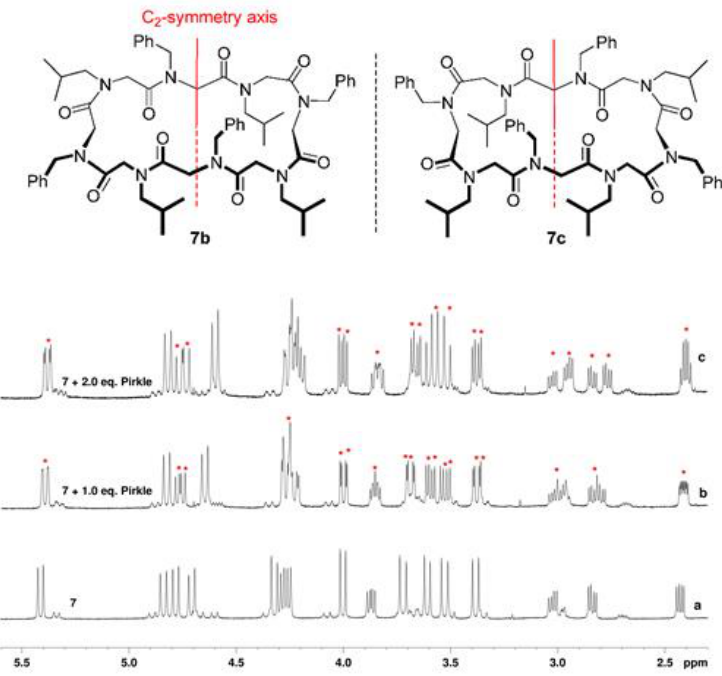
Figure 5. 1 H NMR spectra resulting from the quantitative step-wise addition of Pirkle’s alcohol to the 5.0 mM solution in CDCl 3 (600 MHz). Red asterisks denote split signals.